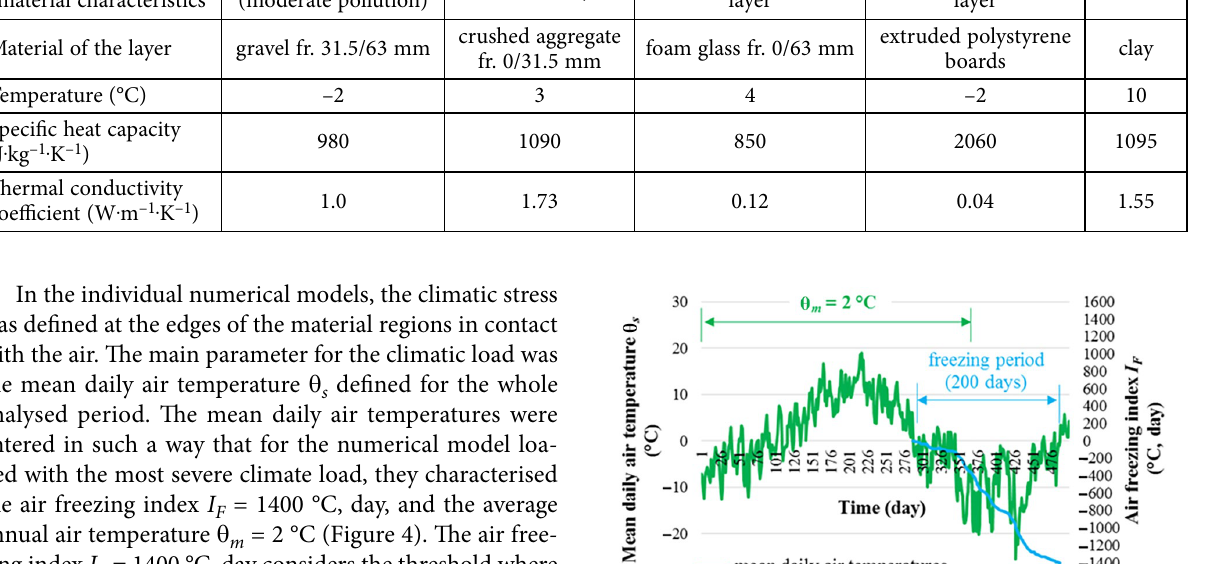
Figure 3. Numerical model (initial design) and use of FlexPDE in the analysis Table 2. Thermal-technical parameters of the materials of the numerical model Construction layer/ material characteristics